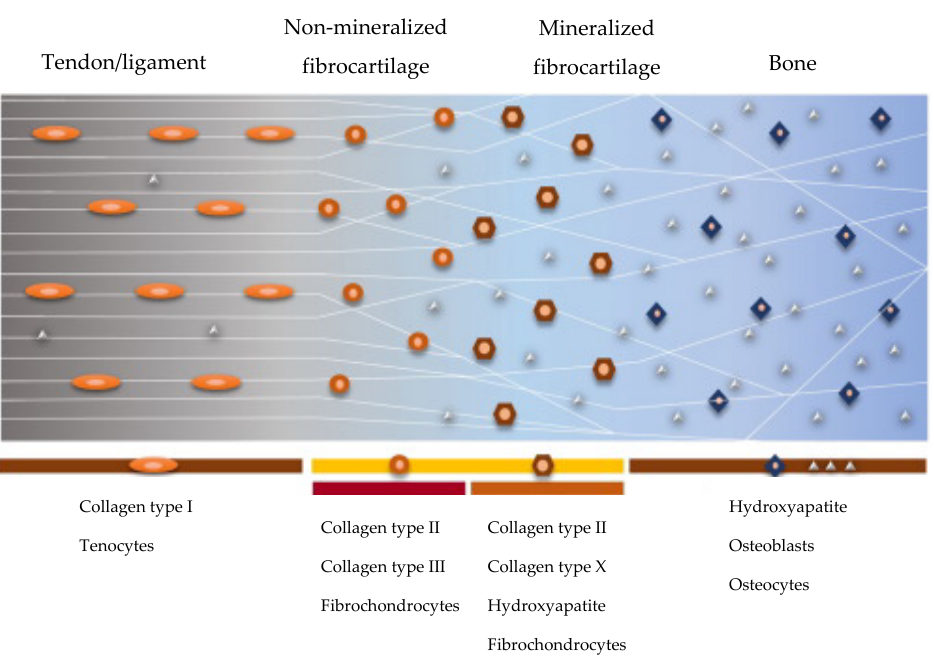
Figure 1. Schematic representation of the structure and composition of the direct enthesis. Adapted with permission from Ref. [3]. Copyright 2022, University of Pavia.